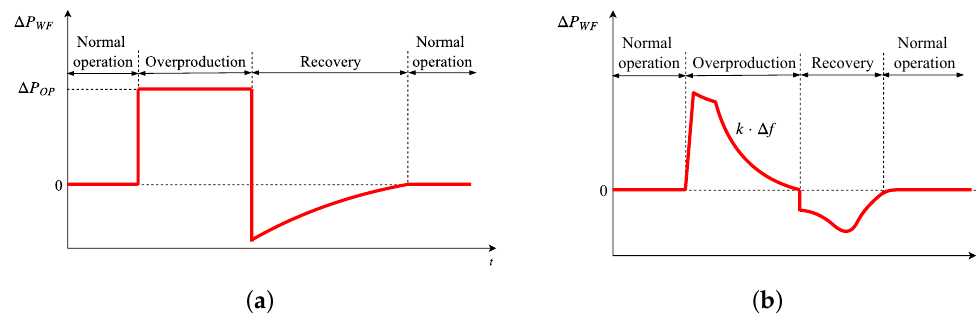
Figure 9. Additional active power of wind power plants: comparison of strategies. ( a ) ∆ P WF in [23]; ( b ) ∆ P WF